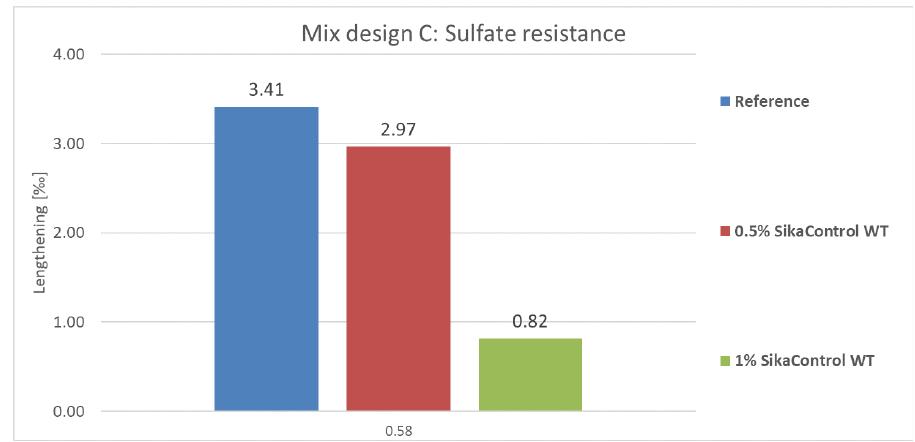
Figure 3. Mix design C: Sulfate